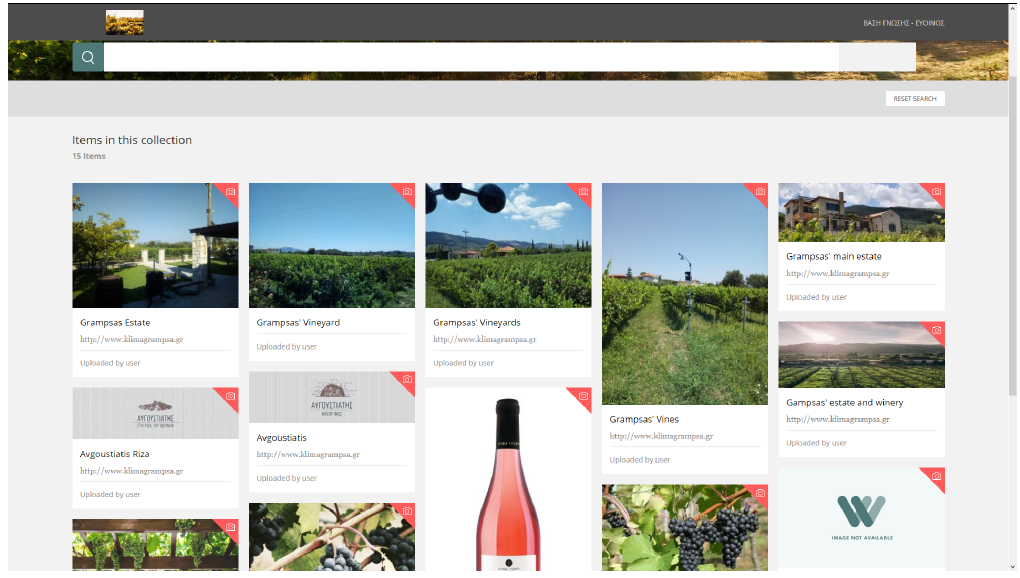
Figure 10. Grampsas